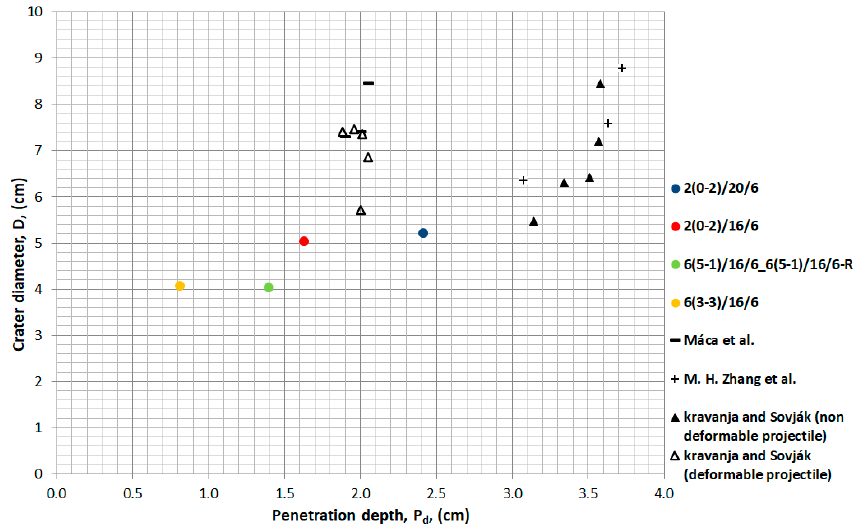
Figure 15. Comparison with literature of penetration depth (Pd) and crater diameter (D). Figure 15 data points correspond to average values from each mixture. Mixtures 2(0-2)/20/6, 2(0-2)/16/6, Máca et al. [20] with 1%, 2%, and 3%, and Kravanja and Sovják (deformable projectile) [14] with 0.125% 0.25%, 0.25%, 0.5%, 1%, and 2% per volume steel fibers have a penetration depth around 2 cm. Crater diameters from literature [14,20] vary between 5.5 and 8.5 cm and are higher than the crater diameters measured in this study which are around 5.0 cm. The difference observed could be attributed to the different